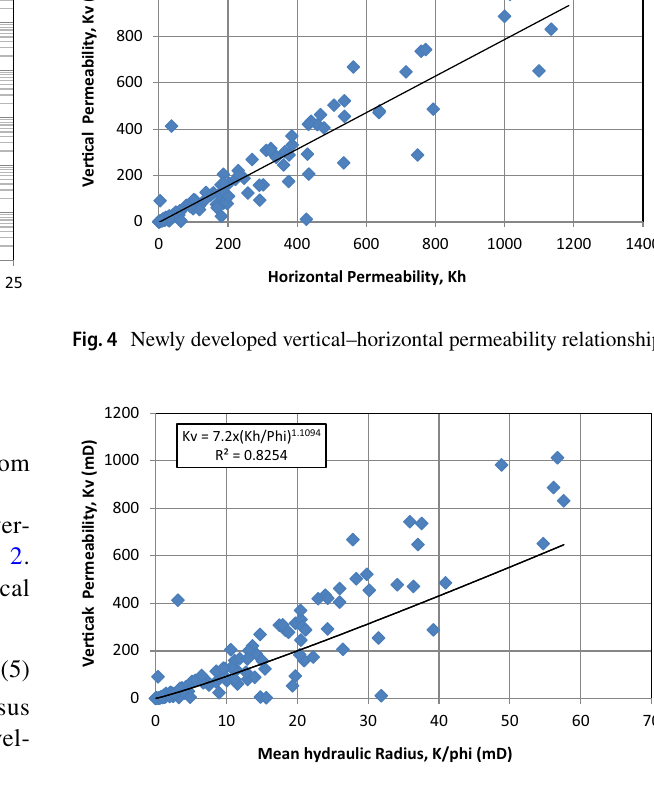
Fig. 5 A plot of vertical perm versus mean hydraulic